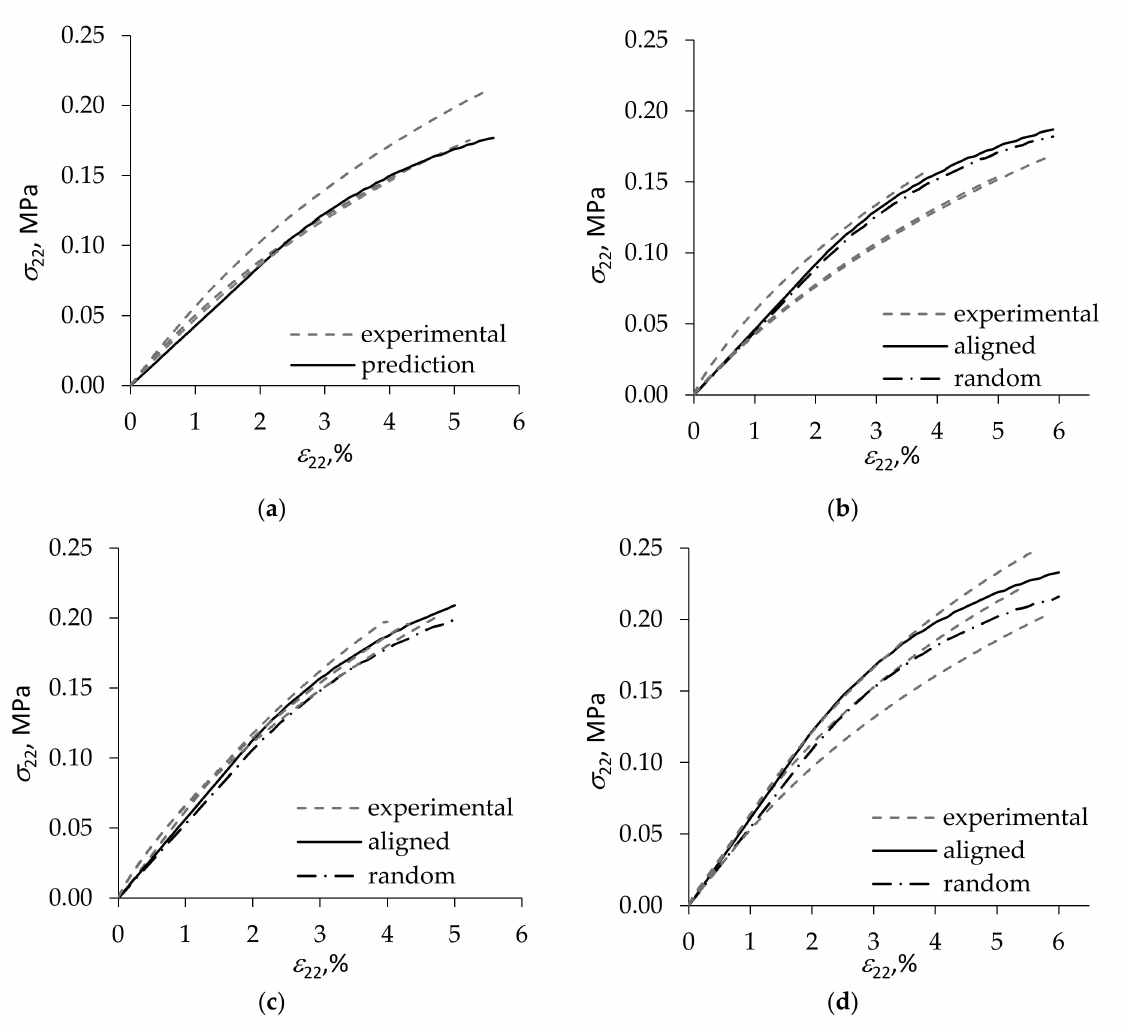
Figure 4. Stress–strain diagrams in tension transverse to the rise direction of ca. 50 kg/m 3 density foams with ( a ) 0, ( b ) 1, ( c ) 2, and ( d ) 3 wt.% loading of Cloisite ® 30B clay. Foam test results are plotted by dashed lines, and model predictions—by solid lines for clay platelets aligned with strut axis and by dash-dot lines for a random orientation of clay platelets in foam